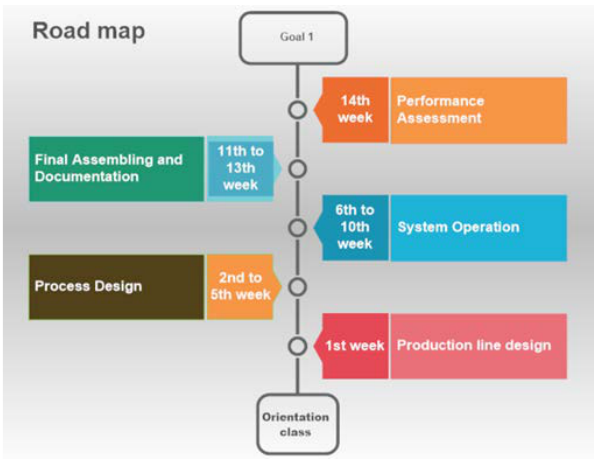
Figure 3. Industry 4.0 short-term course milestones. Figure 2. Industry 4.0 short-term course